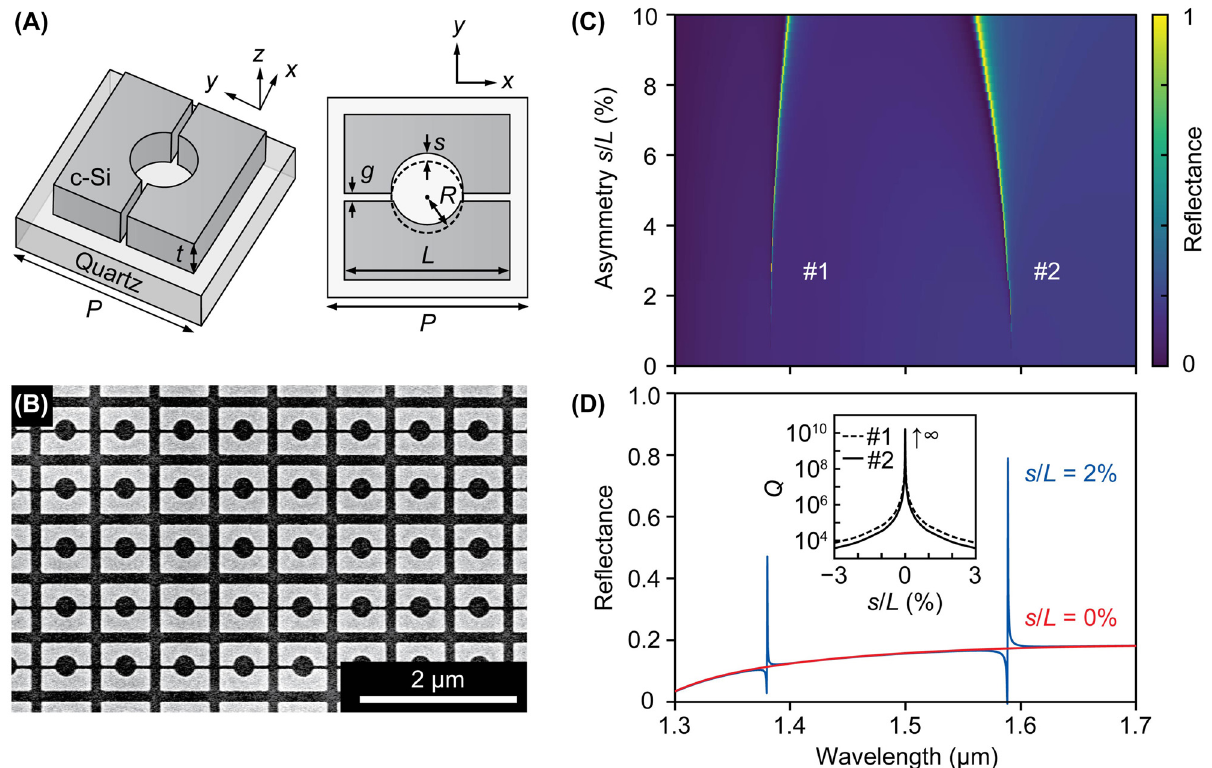
Figure 1: Structure and basic characteristics of all-dielectric metasurfaces with nanogaps. (A) Schematic of the unit cell and the structural parameters depicted in three dimensions (left) and the top view (right). (B) SEM image of a fabricated metasurface with the measured gap size of approximately 33 nm. (C) Simulated contour map of the reflectance spectra for the metasurface with different asymmetries s / L excited by a plane wave along the x direction ( P = 750 nm, L = 580 nm, t = 200 nm, R = 135 nm, g = 30 nm), where the superstrate is assumed to be water ( n = 1.33). The two quasi-BIC modes are denoted as #1 and #2. (D) Simulated reflectance spectra of the metasurfaces with ( s / L = 2%, blue curve) and without ( s / L = 0%, red curve) broken symmetries. Inset shows the calculated Q factors of the two quasi-BIC